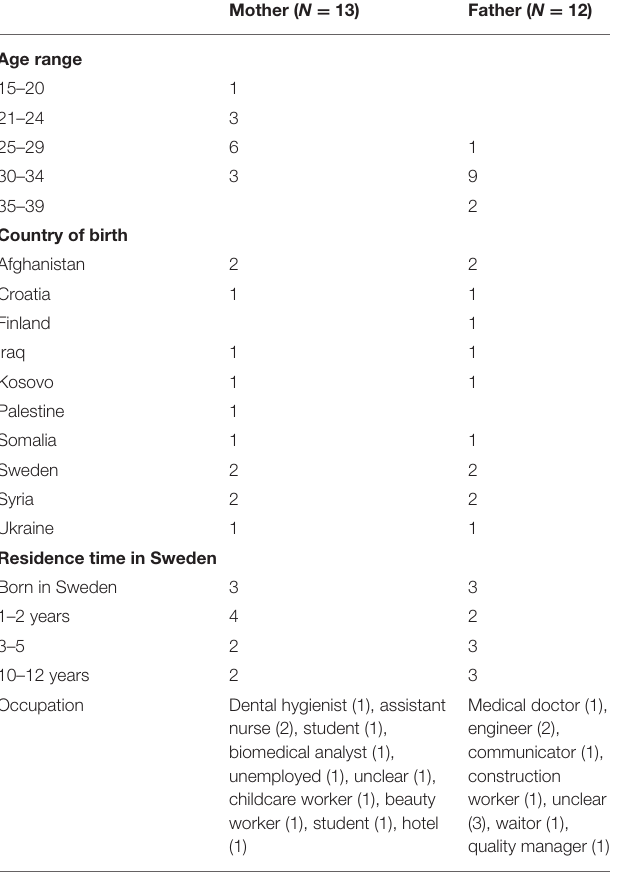
TABLE 1 | Sociodemographic characteristics of participating first-time parents ( N =